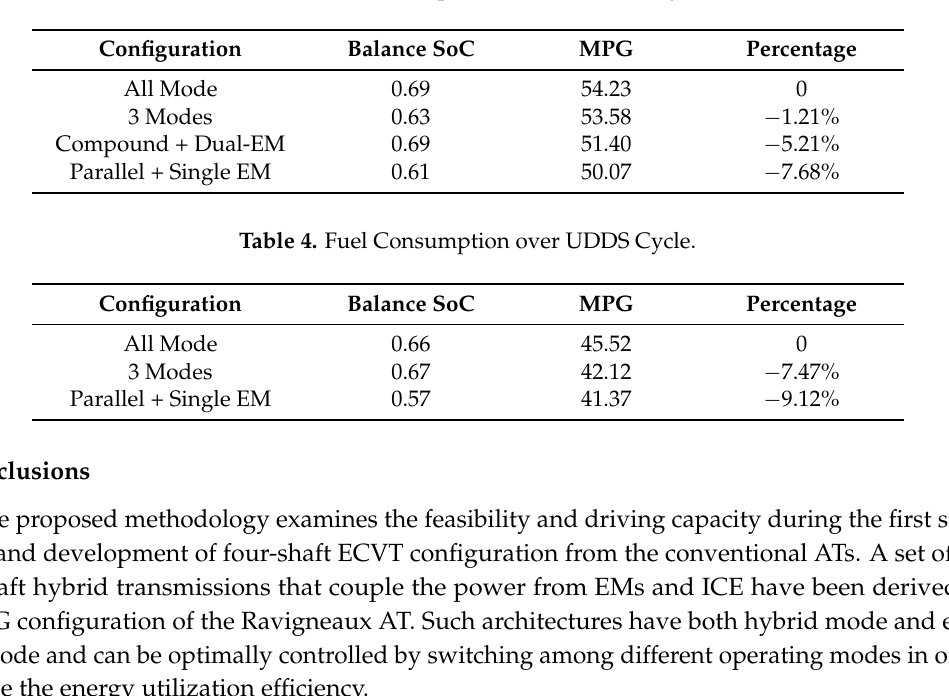
Table 3. Fuel Consumption over the NEDC Cycle.